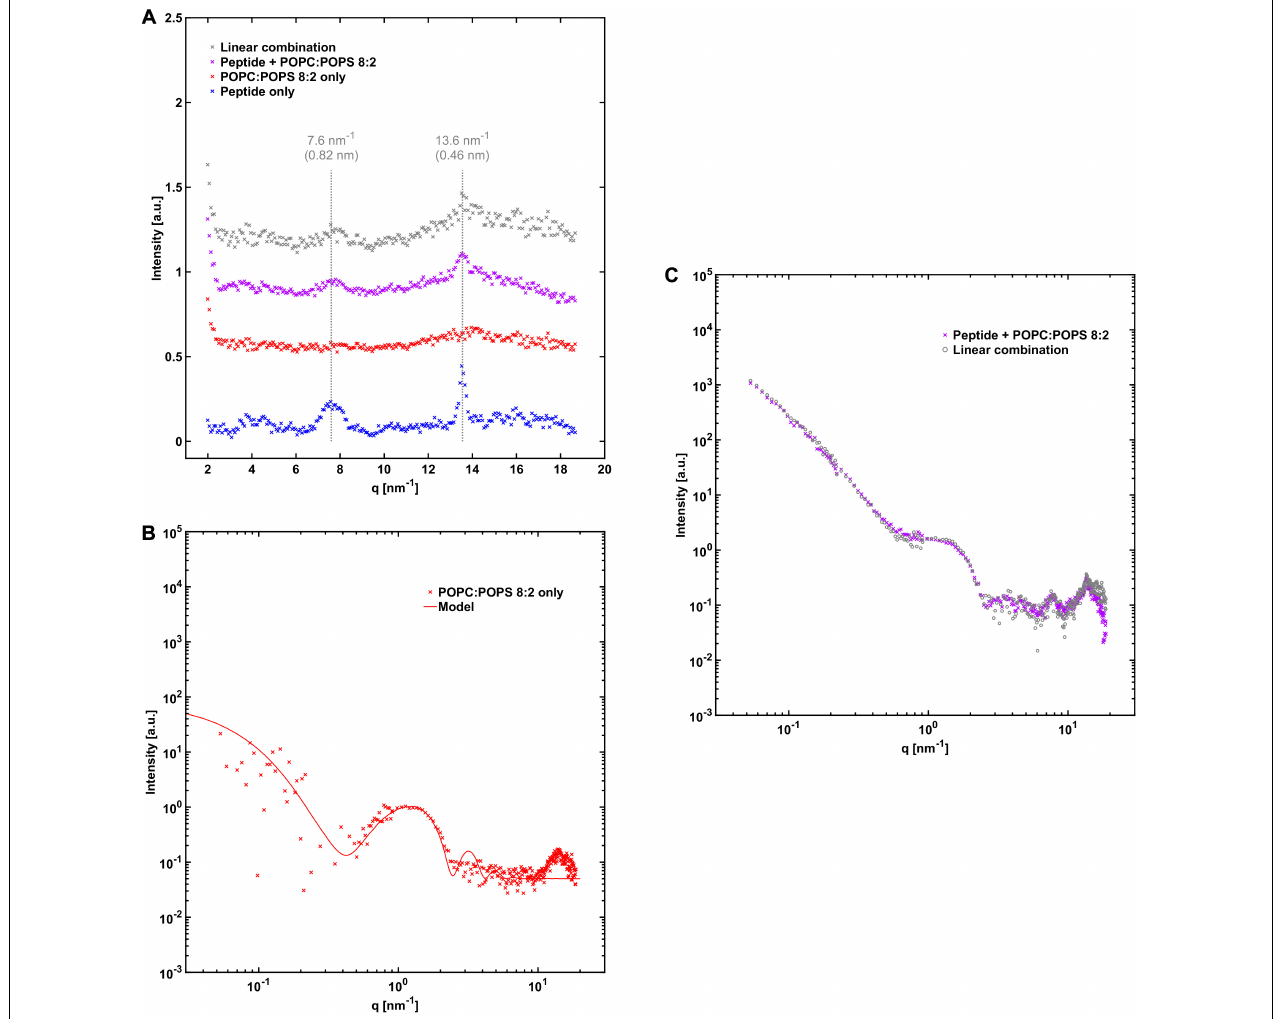
FIGURE 4 | NACore together with POPC:POPS. (A) WAXS profile of NACore with POPC:POPS, POPC:POPS by itself, and the peptide by itself. The position of the two main diffraction peaks are indicated with dashed lines. For comparison, the gray curve shows the expected scattering for the same linear combination as in (C) . (B) SAXS profile of 2.4 mM POPC:POPS without the peptide, together with a simple unilamellar vesicle model fit (see Supplementary Table 1 ). (C) SAXS profile of co-incubated NACore and POPC:POPS, together with a linear combination of scattering from peptide fibrils ( Figure 3B ) and POPC:POPS vesicles (B) (0.40 · fibril + 1.55 ·